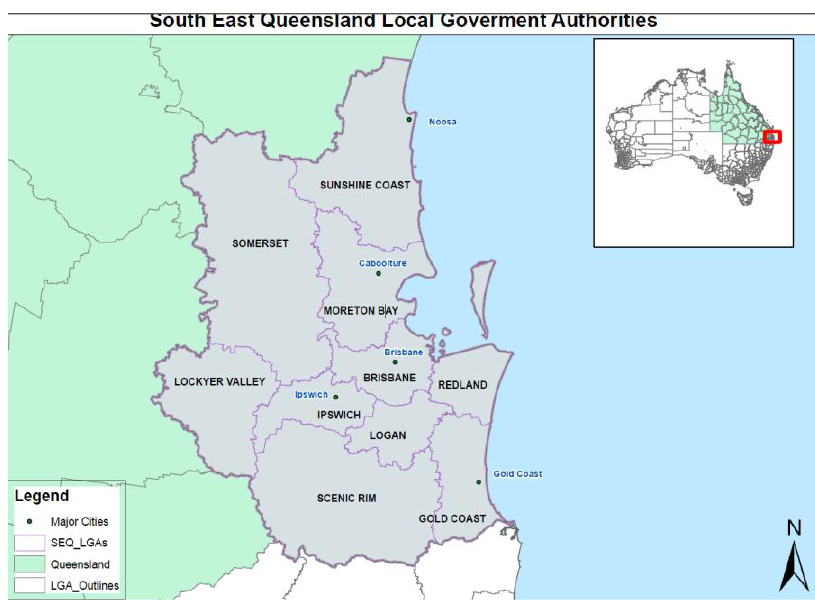
Figure 1. South East Queensland local governments in state and national context.